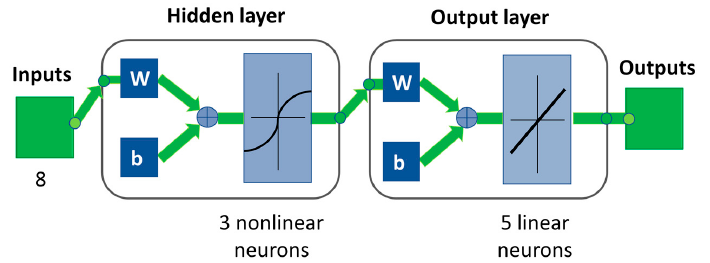
Figure 6. Neural network structure.